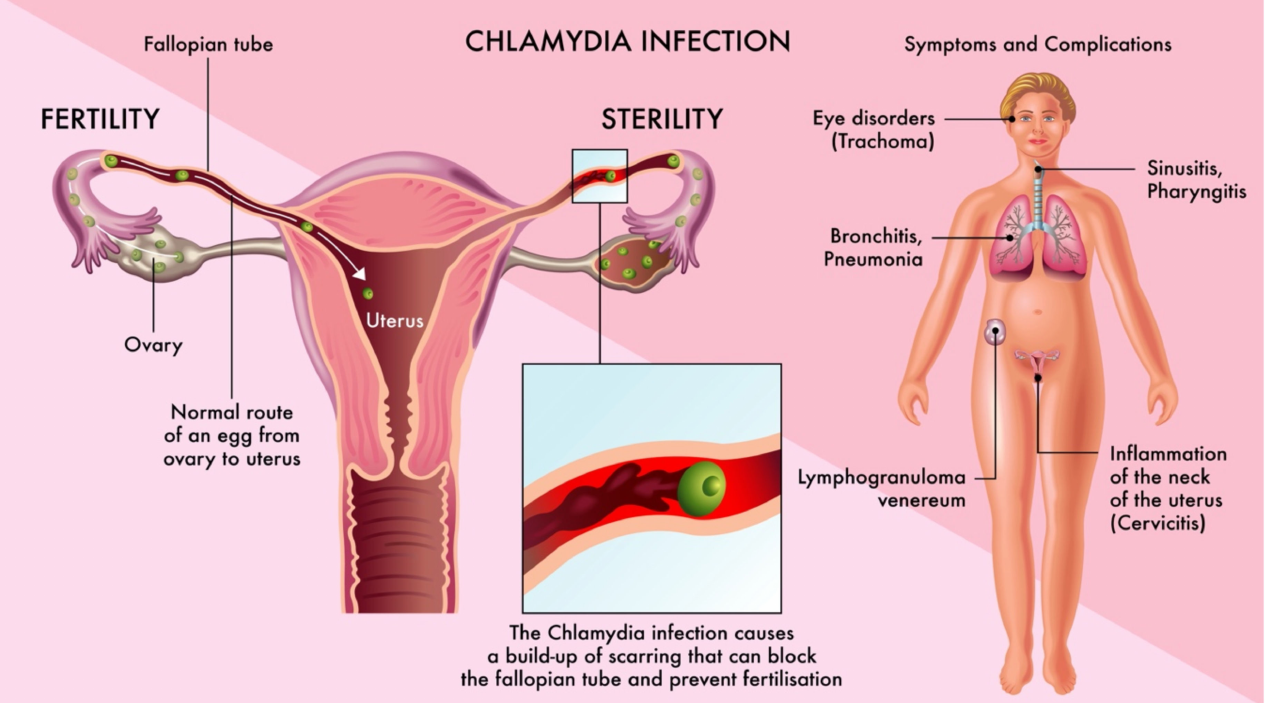
Figure 1. Chlamydia trachomatis infection. Symptoms and possible impact on